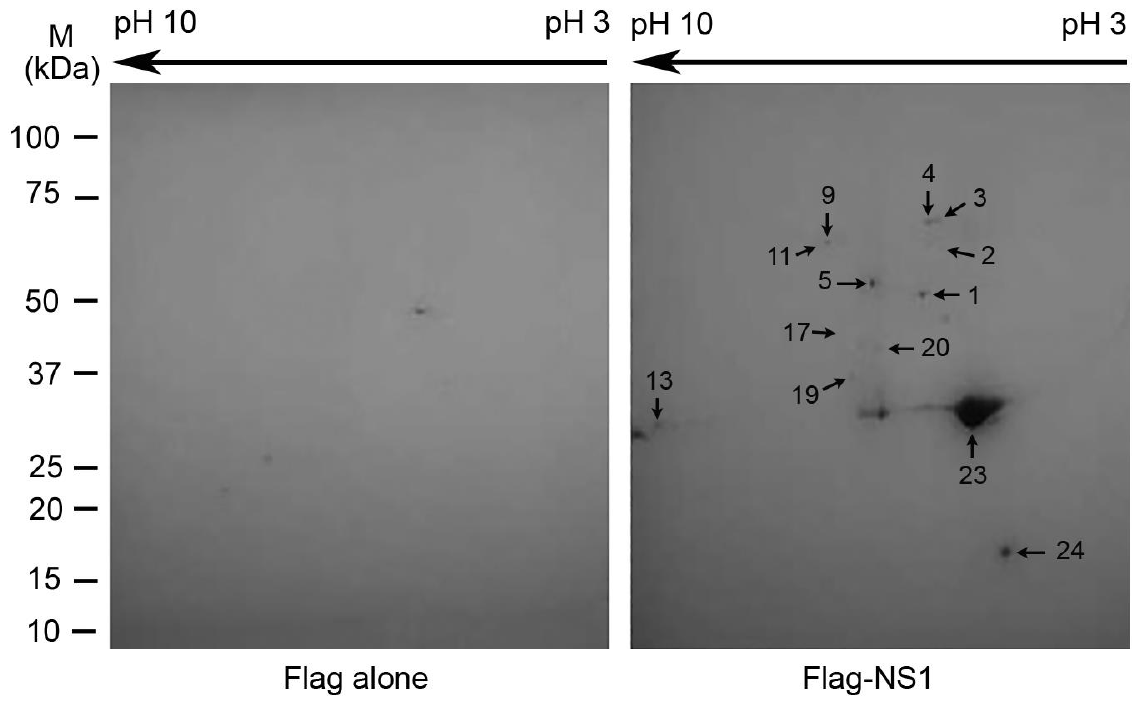
Figure 1. Two-dimensional gel fractionation of the affinity-purified proteins. The Flag-NS1 and its associated proteins were pulled down by immobilized anti-Flag antibody and fractionated with 2-DE. The fractionations of the proteins pulled down from the lysate of the cells expressing Flag alone (control, left panel), and the cells expressing Flag-NS1 (right panel) are shown. The prominent proteins identified in the indicated protein spots by LC-MS/MS are listed in Table 1. Table 1. Short list of proteins identified by affinity purification, 2-DE, and LC-MS/MS analysis a .